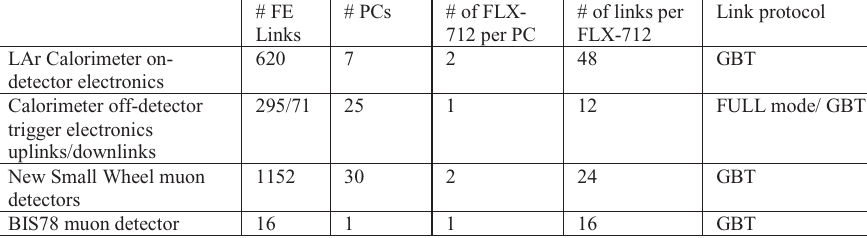
# FE # PCs # of FLX- # of links per Links 712 per PC